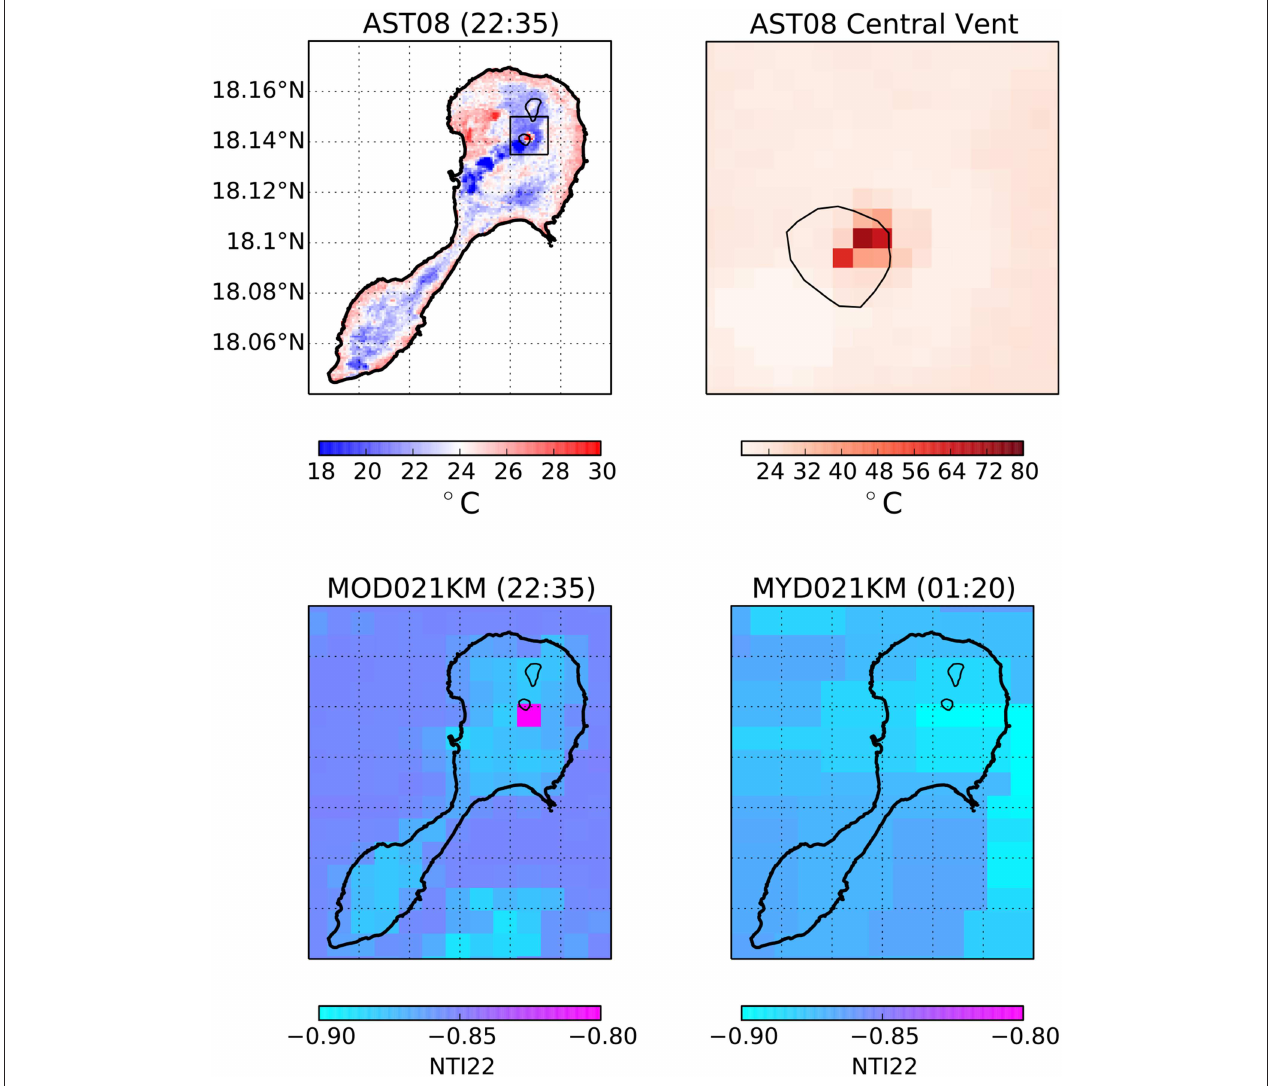
FIGURE 12 | Panel of thermal observations at Pagan 1 day after declared onset of VEI 2 eruption (2012/10/30–2012/12/11). (Upper Left) ASTER Surface Kinetic Temperature (AST08) Image acquired at 22:35 local time. Color scale is centered on mean surface temperature of 24 ◦ C. Elevated temperatures that stand out are lakes, central vent of Mt. Pagan, and several pixels within crater of Bulikan Bulifli. Summit vent of Mt. Pagan shown in image to right on separate color scale. (Lower Left) Terra MODIS Normalized Thermal Index (NTI) image acquired simultaneously with ASTER, showing pixel triggering MODVOLC alert aligned with the central vent (sensor zenith angle = 2.5 ◦ , sensor azimuth angle = − 91 ◦ , NTI = − 0.79). (Lower Right) Aqua MODIS NTI image acquired 3 h later showing pixel stretching characteristic of large sensor zenith angles (sensor zenith angle = 61.6 ◦ , sensor azimuth angle = 96 ◦ , NTI = − 0.88).